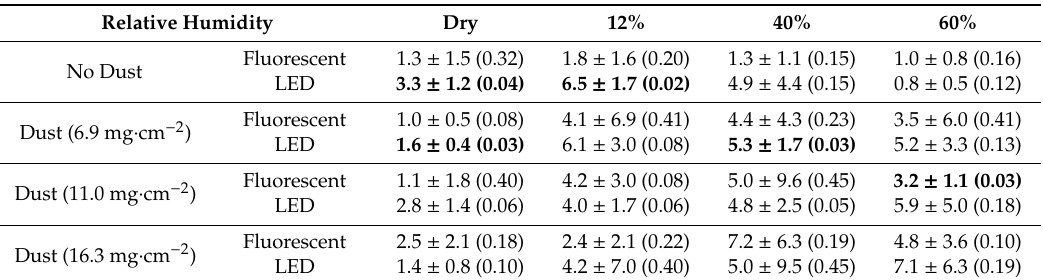
Table A8. N 2 O mitigation under the di ff erent dust levels at a treatment time of 200 s in direct photolysis. Values in the table report % reduction ± standard deviation ( p -value) and are an average between treatments of NH 3 and H 2 S standard gases. Bold font signifies statistical significance.